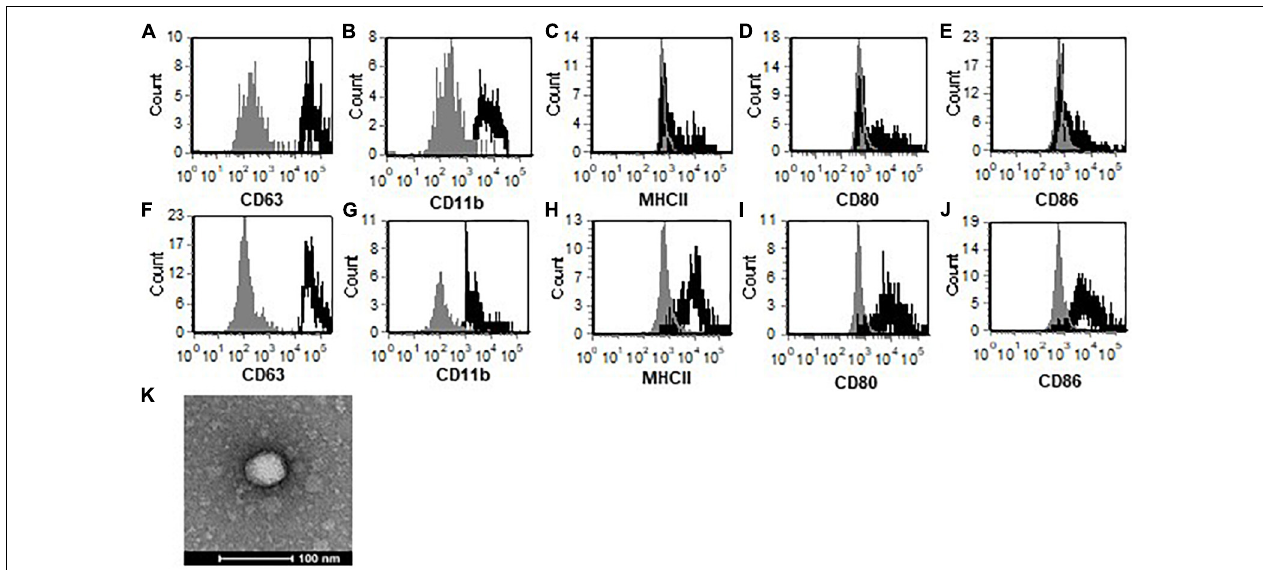
FIGURE 1 | TMEV-infected microglia secrete exosomes that contain activation markers. Exosomes were isolated from uninfected (A–E) or TMEV infected microglia (F–J) . The exosomes were labeled with fluorescently labeled antibodies for CD63 (A,F) , CD11b (B,G) , MHC class II (C,H) , CD80 (D,I) , and CD86 (E,J) . The exosomes were analyzed by flow cytometry for expression of specific markers as shown in the black line compared to isotype control antibodies in the gray line. (K) Isolated exosomes were analyzed by transmission electron microscopy and determined to be 40–80 nm. One representative image is shown. These are representative graphs and images from one experiment of four independent repeated experiments.